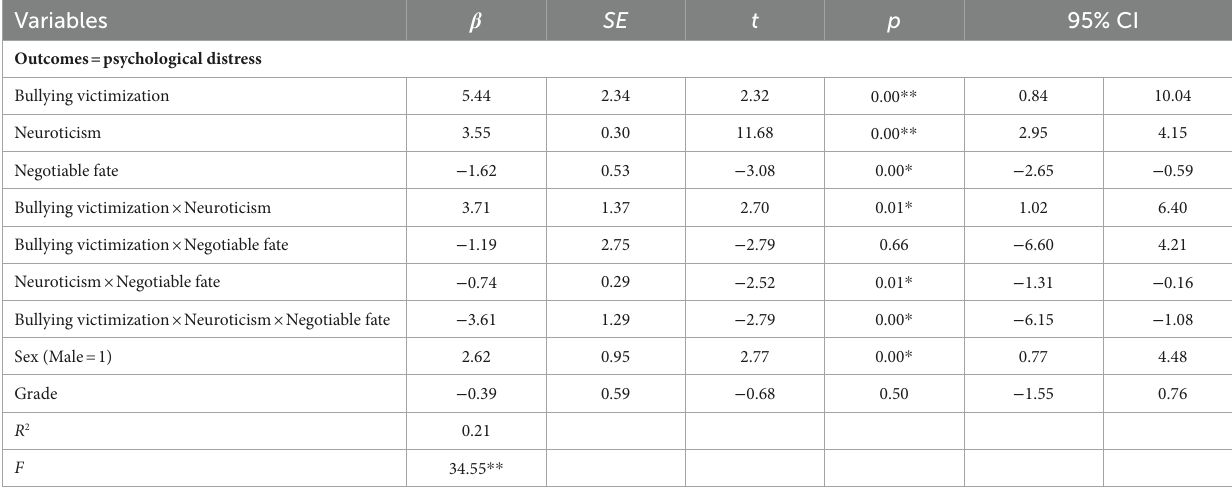
Sex coded as 1 = Male, 2 = Female. Grade is coded as 1 = Grade 10th, 2 = Grade 11th, 3 = Grade 12th. * p < 0.05; ** p < 0.01. These values are based on unstandardized path coefficients. All parameter estimates and significance tests are based on 5,000 bootstrapped samples. Significant effects are determined by both 95% CI that does not include zero. Covariates included participants’ sex and grade.